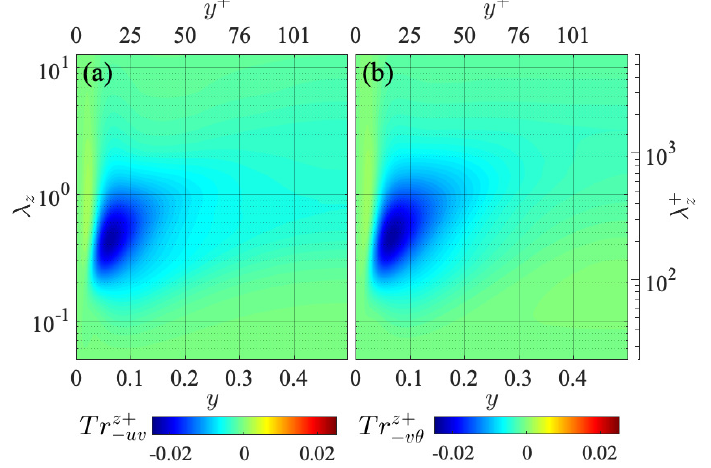
Figure 6. Spanwise interscale fluxes of ( a ) Reynolds shear stress Tr z − uv and ( b ) turbulent heat flux Tr z − , presented in the same manner as in Figure v θ